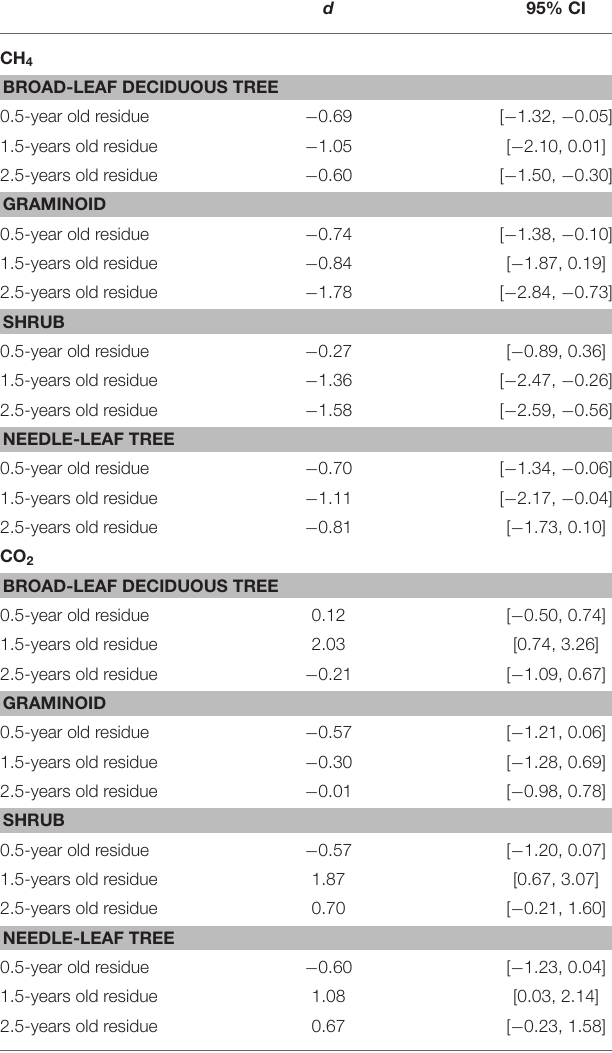
Traits of green leaves varied among the nine species ( Table 1 ): the variation was greater for SLA (Coefficient of Variation, CV = 52% among the nine species) than for LDMC (CV = 25%). In general, green leaves with longer life span (LLS) had smaller values for SLA, whereas LDMC was lower for the broad-leaf deciduous tree species and graminoid species than for the shrub species and needle-leaf tree species. The cell wall composition of leaf litter ( Table 3 ) revealed greater concentrations of pectin and cellulose than concentrations of lignin, hemicellulose, and soluble components. Overall cell wall pectin was the least variable component among the nine species (CV = 13%). Pectin in the middle lamella (CV = 32%), cellulose (CV = 41%), and lignin (CV = 36%) were moderately variable, whereas N (CV = 64%), soluble components (CV = 60%), and hemicellulose (CV =